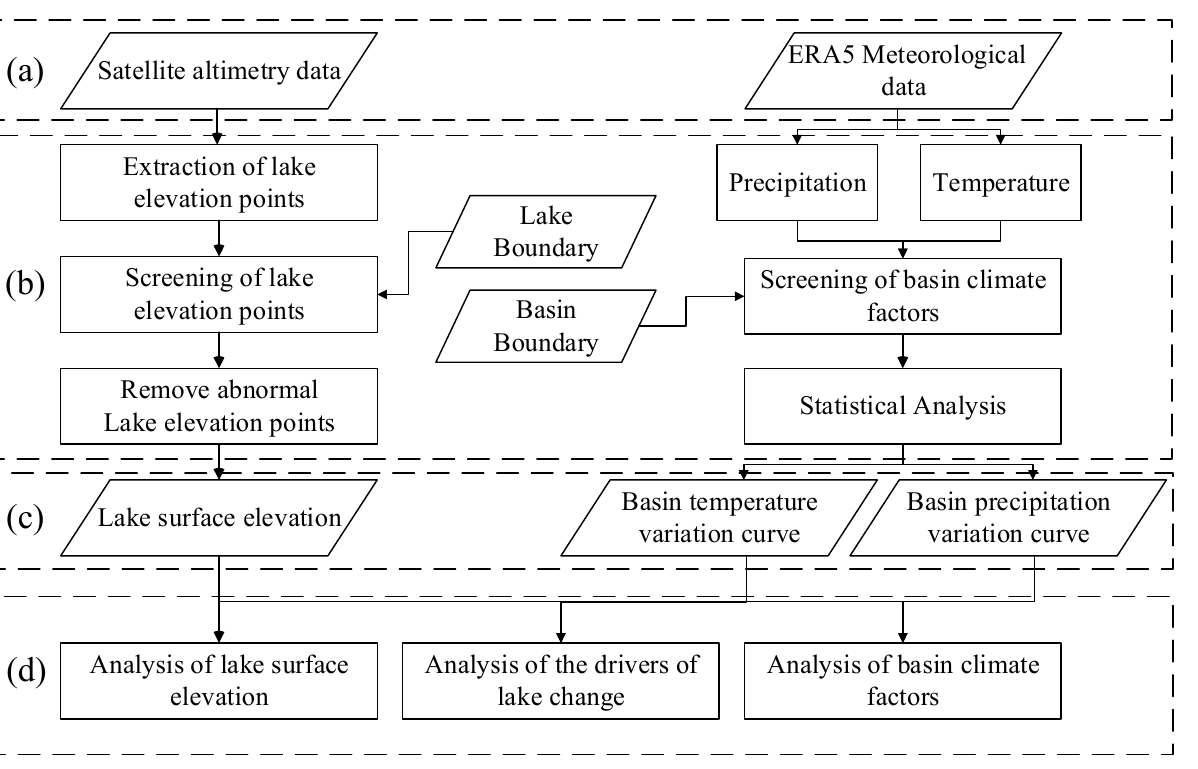
Figure 4. ( a ) Time series of the surface elevation of Lake Bosten based on CryoSat-2 satellite and Hydroweb data. ( b ) Time series of the surface elevation of Lake Issyk-Kul based on CryoSat-2 satellite and Hydroweb data.